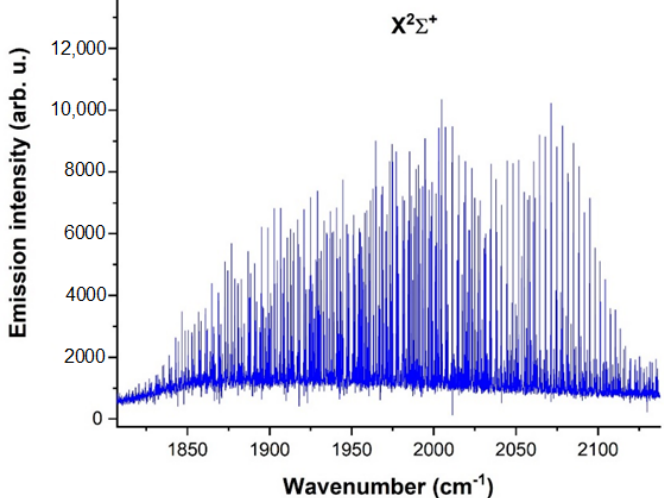
Figure 22. Several rotational-vibrational bands of CN radical in the X 2 Σ + ground state. A comprehensive spectrum of the CN radical in the 2150–3250 cm − 1 spectral range, demonstrating A 2 Π → X 2 Σ + transitions, is depicted in Figure 23, where a total of 6 bands were measured. The spectrum was obtained under the same conditions as the spectrum in Figure 22. Figure 23. Spectrum of electronic bands of CN radical for the Δ v = − 3 sequence (39 µs). A sequence of the Δv = − 2 of A 2 Π → X 2 Σ + transition type of the CN radical, lying in the 4350–5150 cm − 1 spectral range, is depicted in Figure 24 and was obtained by the use of (CN) 2 , with a pulse width of 22 and 14 µs after the pulse ended. The spectral resolution was 0.05 cm − 1 , and 50 scans were accumulated to obtain a reasonable signal-to-noise ratio. The electric voltage was 1.4 kV, and the electric current was 100 mA.